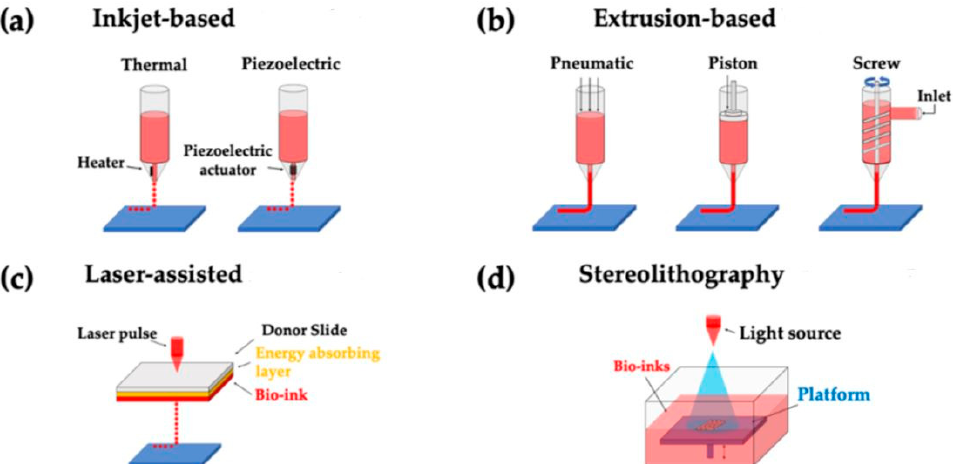
Figure 2. Four main bioprinting methods. ( a ) Inkjet Bioprinting. ( b ) Extrusion Bioprinting. ( c ) Laser- Assisted Bioprinting. ( d ) Stereolithography Bioprinting were reprinted with permission from